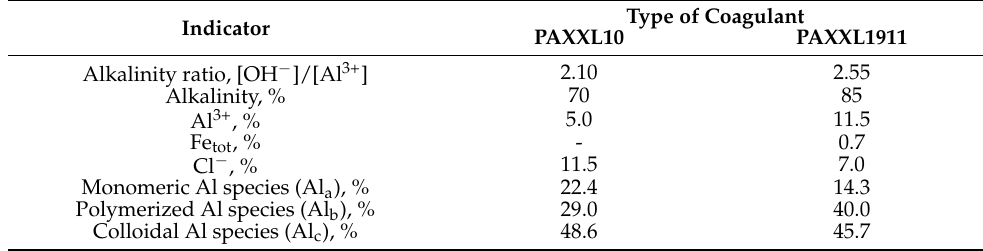
Table 5. Selected properties of the tested coagulants and the degree of polymerization of the coagu- lants according to the conventional ferronometry [51,52].